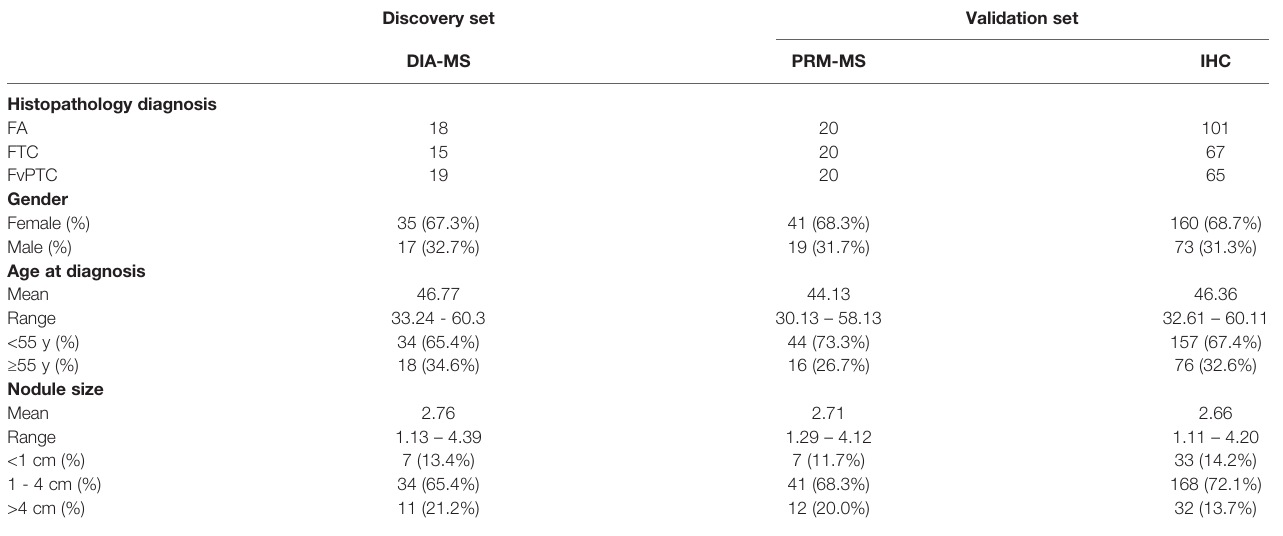
TABLE 1 | Clinical characteristics in DIA-MS, PRM-MS, and IHC